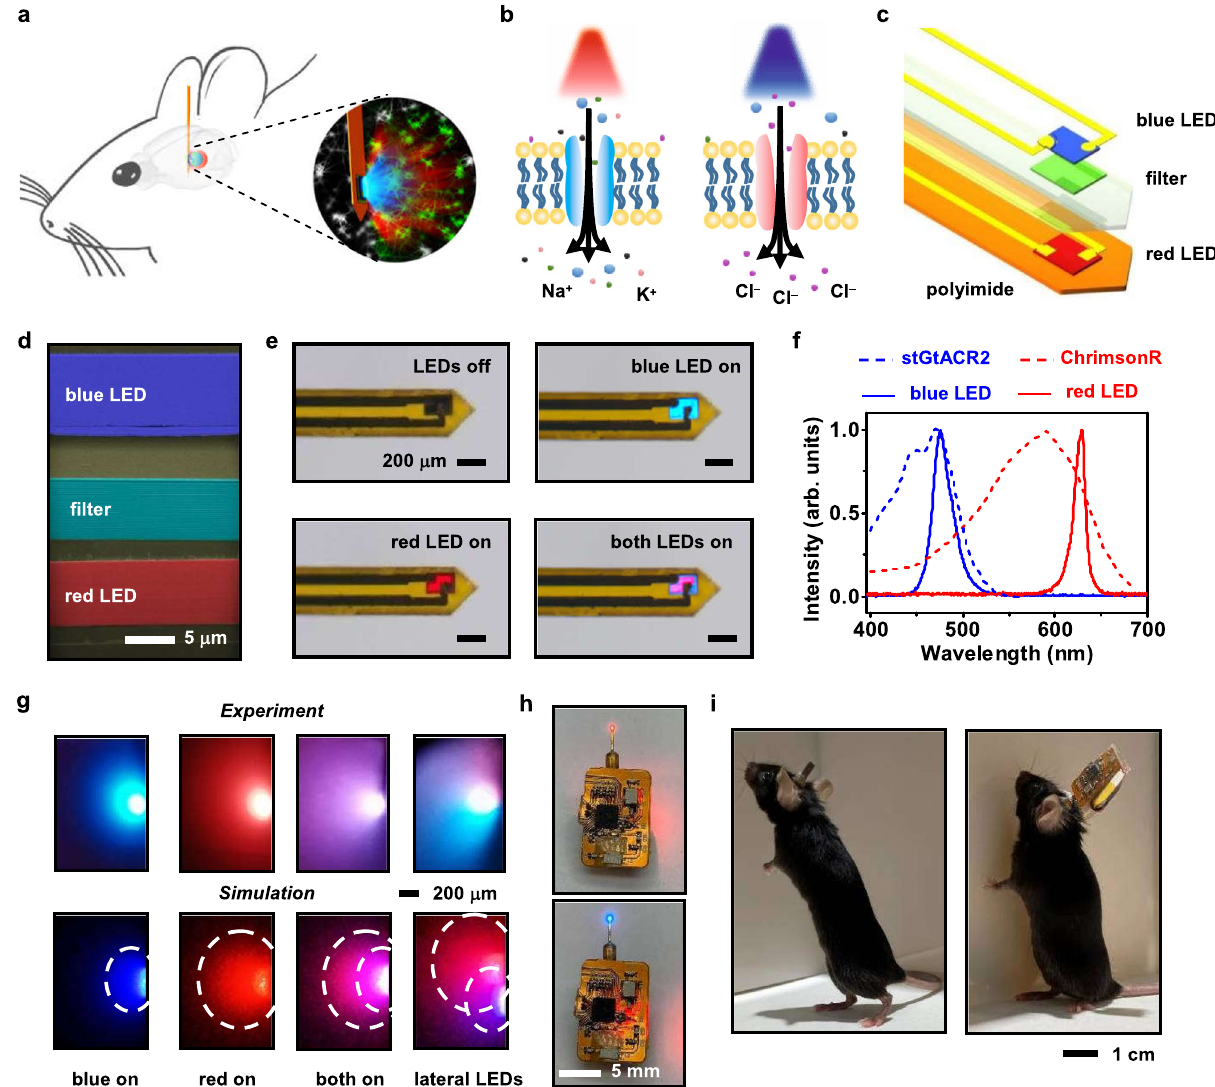
Fig. 1 Wirelessly operated, dual-color microscale LED (micro-LED) probes for bidirectional, colocalized optogenetic control of neural activities. a Schematic view of the probe inserted into the target brain area to perform dual-color neural activation and inhibition. b Schematic, cellular scale depiction of the modulation function: red light regulates the cation channel ChrimsonR for depolarization, while blue light regulates the anion channel stGtACR2 for hyperpolarization. c Exploded view of the dual-color LED probe made from vertically stacked blue and red thin- fi lm micro-LEDs assembled on a fl exible polyimide (PI) substrate, with a thin- fi lm fi lter interface for spectrally selective re fl ection and transmission. d Cross-sectional scanning electron microscopic (SEM) image of the probe structure, with false colors highlighting (from bottom to top) the indium gallium arsenide (InGaP) red micro-LED, the multilayer silicon dioxide/titanium dioxide (SiO 2 /TiO 2 ) fi lter, and the indium gallium nitride (InGaN) blue micro-LED. Layers of SU-8 photoresists serve as bonding materials. e Optical images of a micro-LED probe (with a thickness of ~120 µ m and a width of ~320 µ m), showing independent control of blue and red emissions under current injections. f Emission spectra of the blue and red micro-LEDs, in comparison with the action spectra of ion channels stGtACR2 and ChrimsonR. g Experimental photographs and simulated results illustrating blue and red light propagations for a micro-LED probe embedded into a brain phantom (columns 1 – 3). Results for a probe with laterally assemble blue and red LEDs are also presented (column 4), showing misplaced blue and red emissions. Iso-intensity lines show 10% of the maximum power. h Images of a micro-LED probe integrated with a wireless circuit for independent control of dual-color emissions. i Photos of a behaving mouse after intracranial implantation of a probe, with (right) and without (left) the wireless circuit module. Source data are provided as a Source Data fi